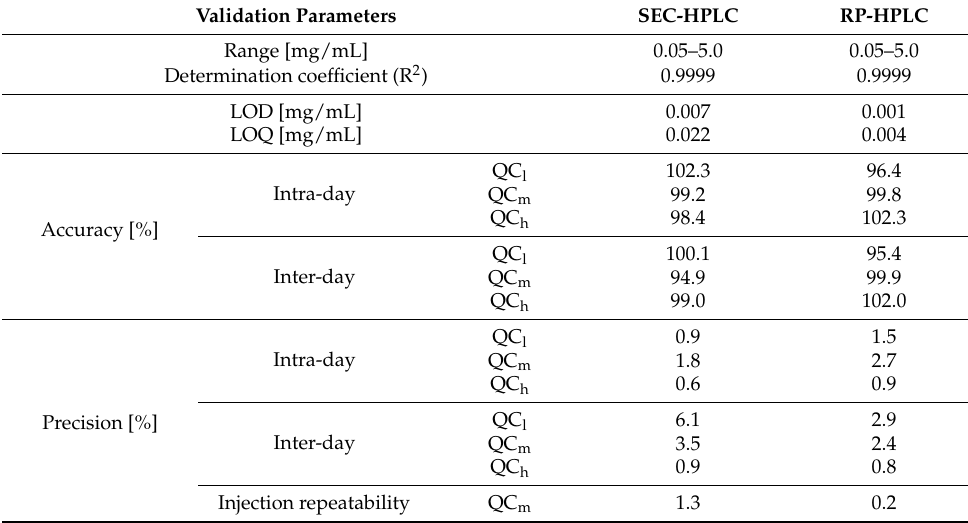
Table 3. Validation data for RP-HPLC and SEC-HPLC